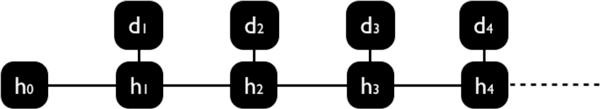
The hidden Markov model. The state of an unobserved Markov chain hτ evolves over time τ according to transition kernel tτ (·|hτ-1). At each time the observed datum dτ is distributed according to the "emission" distribution eτ (·|hτ), which depends on the current state of the hidden Markov chain.